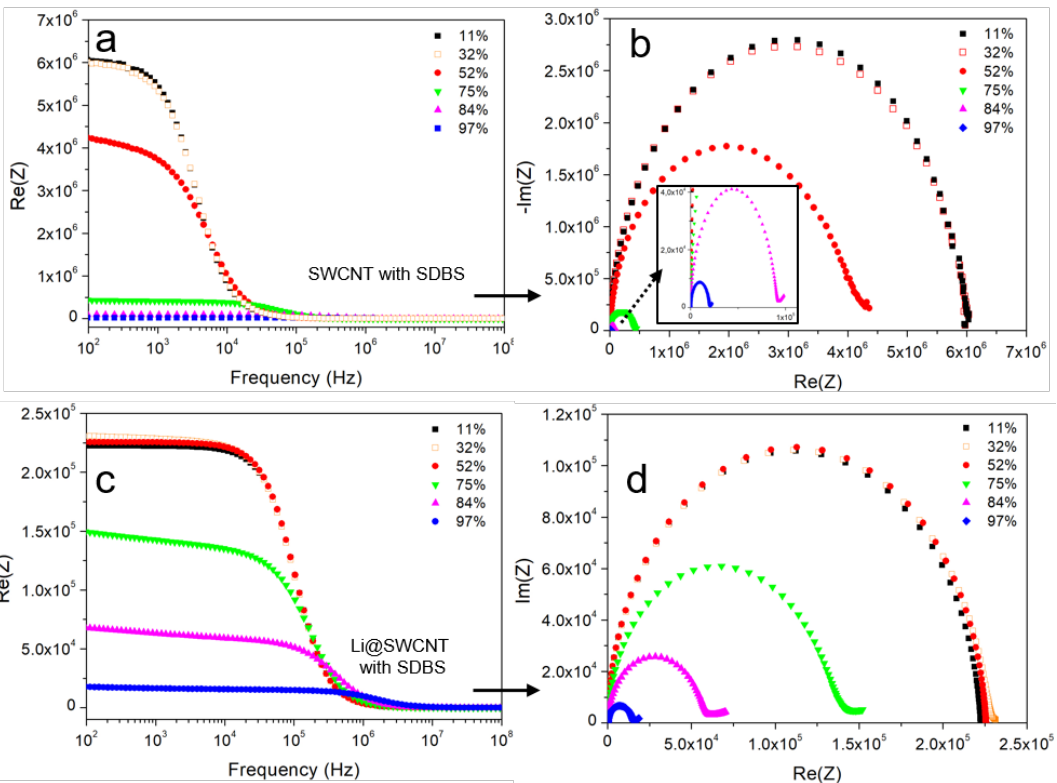
Figure 7. Impedance spectra in the humidity range of 11–97% of: ( a ) Bode plot of undoped SWCNT/SDBS films.